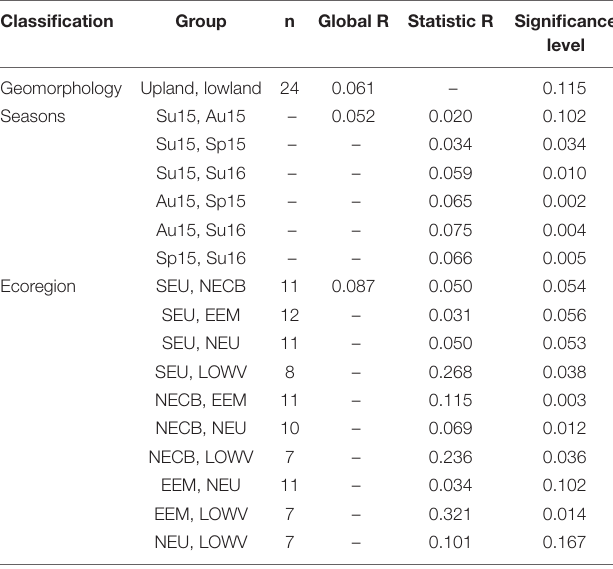
TABLE 4 | Pairwise tests of the analysis of similarity (ANOSIM), indicating the Global R, and Statistic R -values in the present study. Classification Group